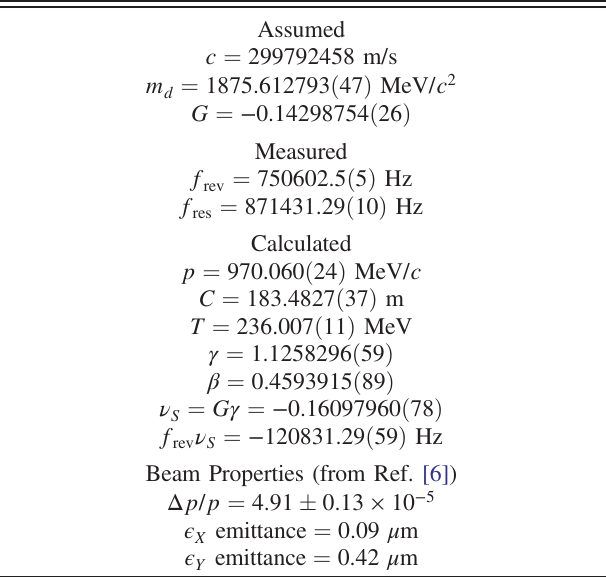
TABLE I. Machine and beam